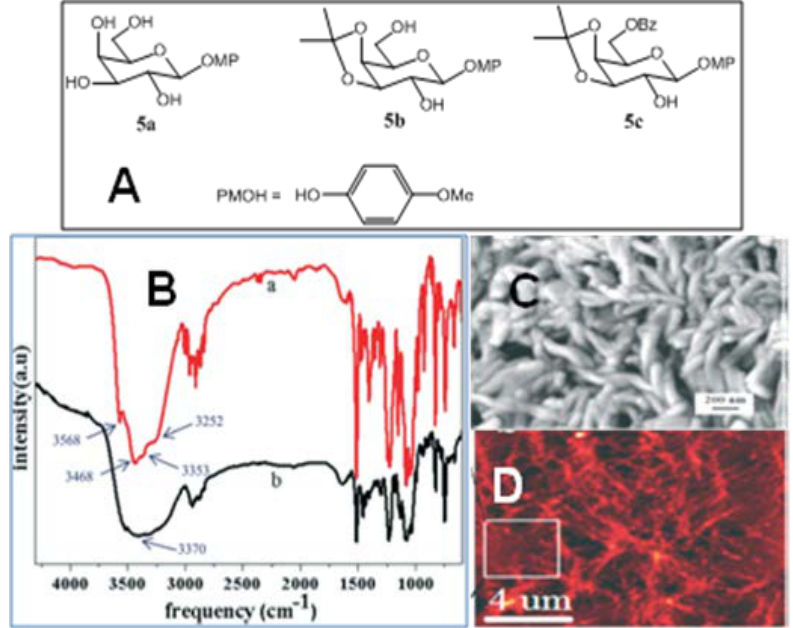
Figure 4. ( A ) Structures of the sugar compounds; ( B ) FT-IR spectra of compound 5a in (a) crystalline state and (b) xerogel state (0.25% w / v in 1,2-dichlorobenzene); ( C ) Field emission scanning electron microscopy (FE-SEM) image of the gel of 5a in 1,2-dichlorobenzene at their CGCs, the scale bar is 200 nm; ( D ) AFM images of the gels of 5a in 1,2-dichlorobenzene. Reprinted with permission from [64]. Copyright 2015 Royal Society of Chemistry.